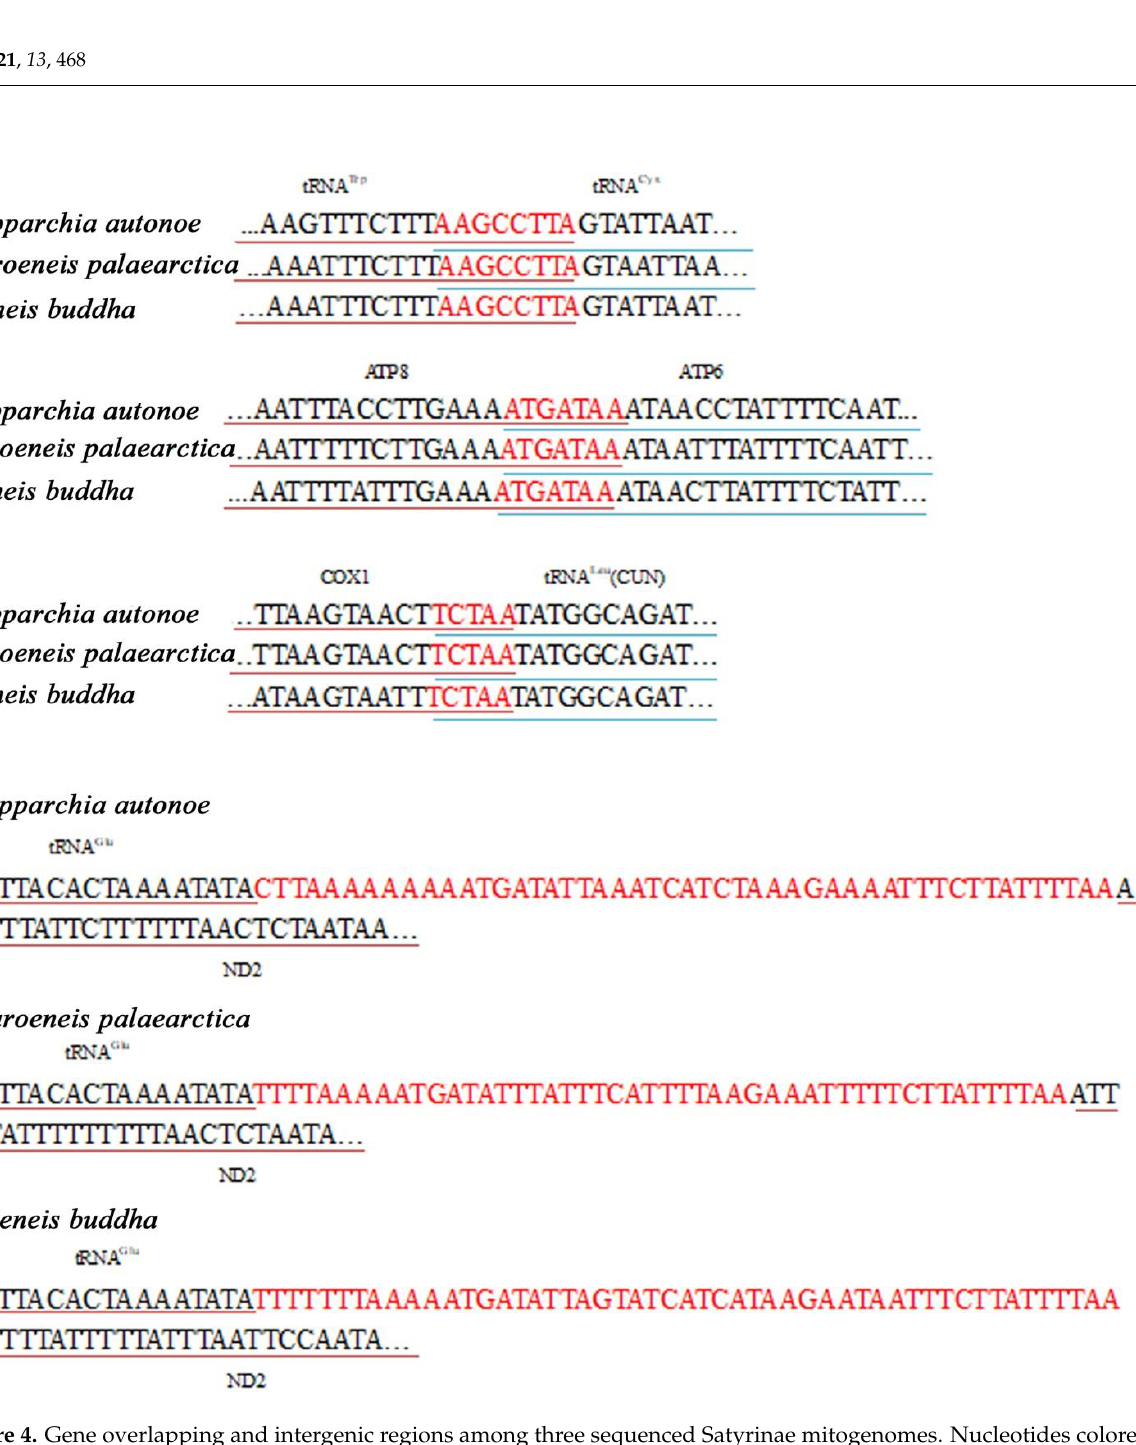
Figure 4. Gene overlapping and intergenic regions among three sequenced Satyrinae mitogenomes. Nucleotides colored red indicate the sequences of the overlapping or intergenic regions except where further explained. ( A ) The overlapping region between tRNATrp and tRNACys. ( B ) The overlapping region between ATP8 and ATP6 . ( C ) The overlapping region between COX1 and tRNALeu (CUN). ( D ) The intergenic region between tRNAGlu and ND2